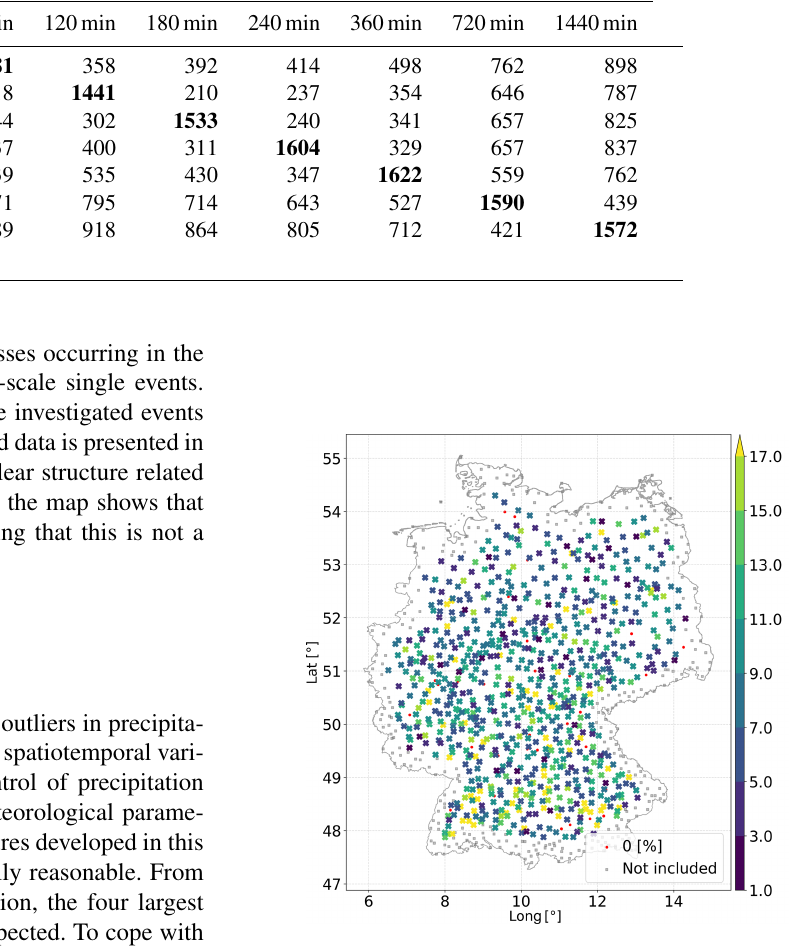
Figure 5. Location of the discharge and rain gauge station within the Pegnitz headwater catchment (a) . Observed discharge and precipitation data ( ± 1d) for detected outliers with (b) a discharge increment and (c) without a discharge increase. Table 3. The diagonals show the total number of detected outliers per aggregation. The values above the diagonals reflect the number of different days between the reference and test aggregation. For example, there are 358d in the reference 60min aggregation that are not in the test with the 120min aggregation. Test